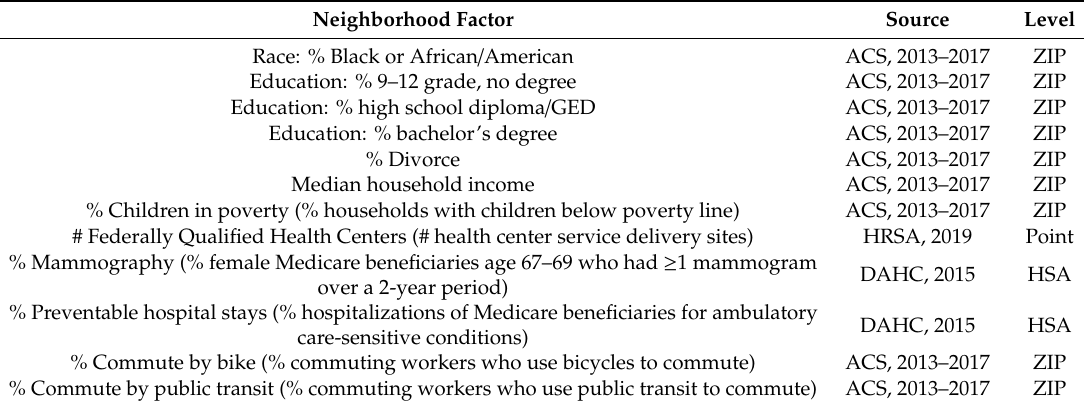
Table 1. Summary of 12 Neighborhood-Level Factors and Data Sources. Neighborhood